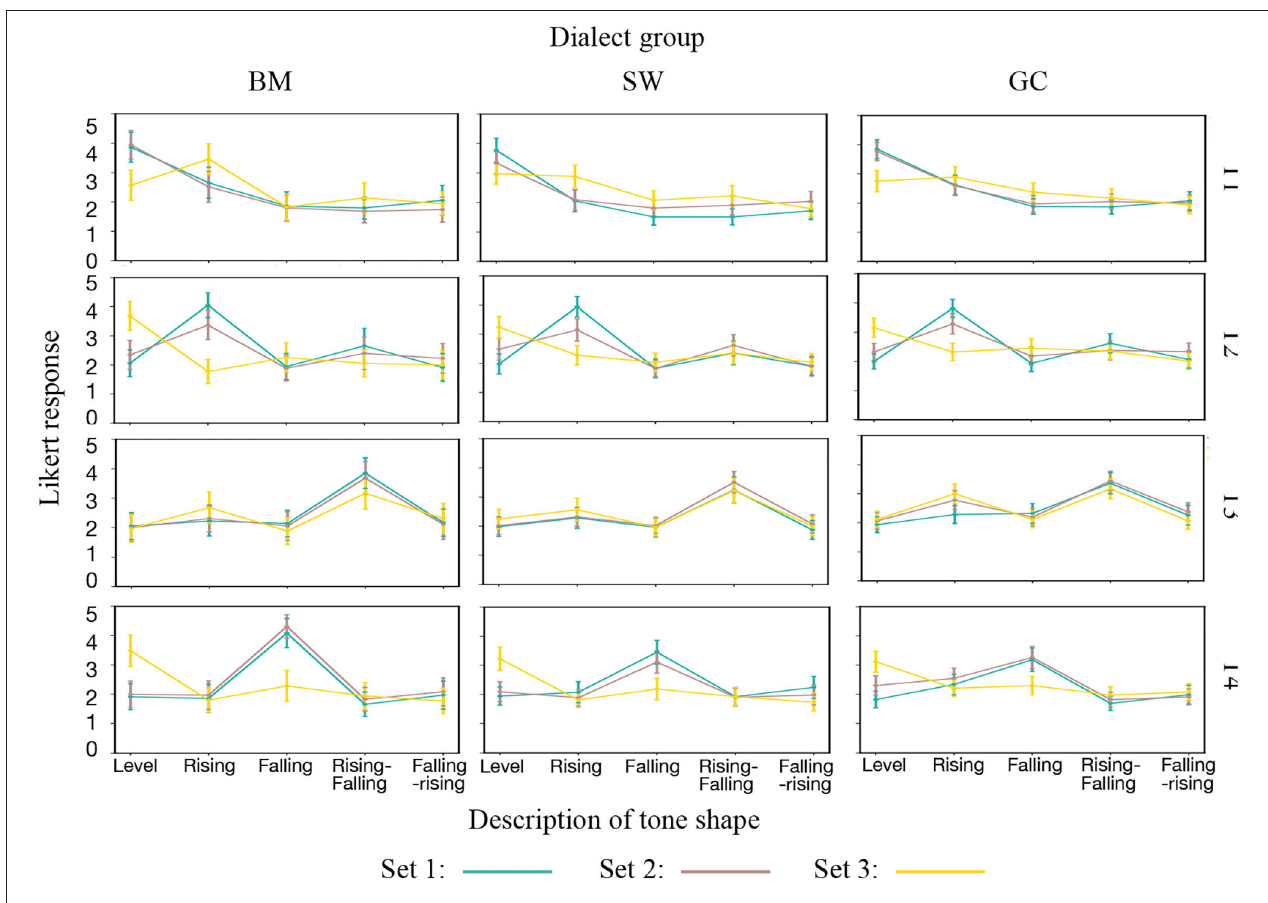
FIGURE 6 | Set curve for shape descriptors separated by tone and dialect